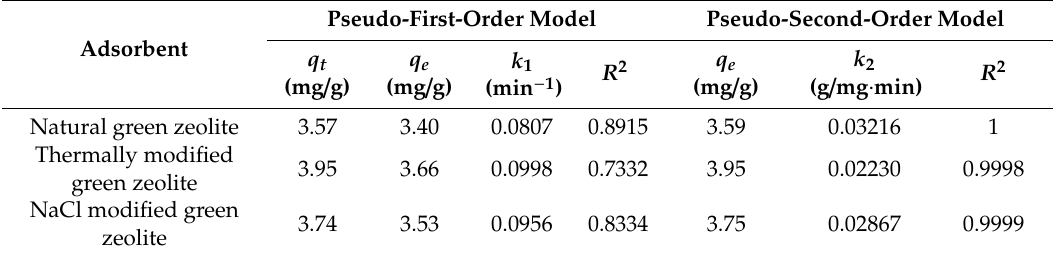
Table 1. Adsorption kinetic parameters of three kind of zeolites onto